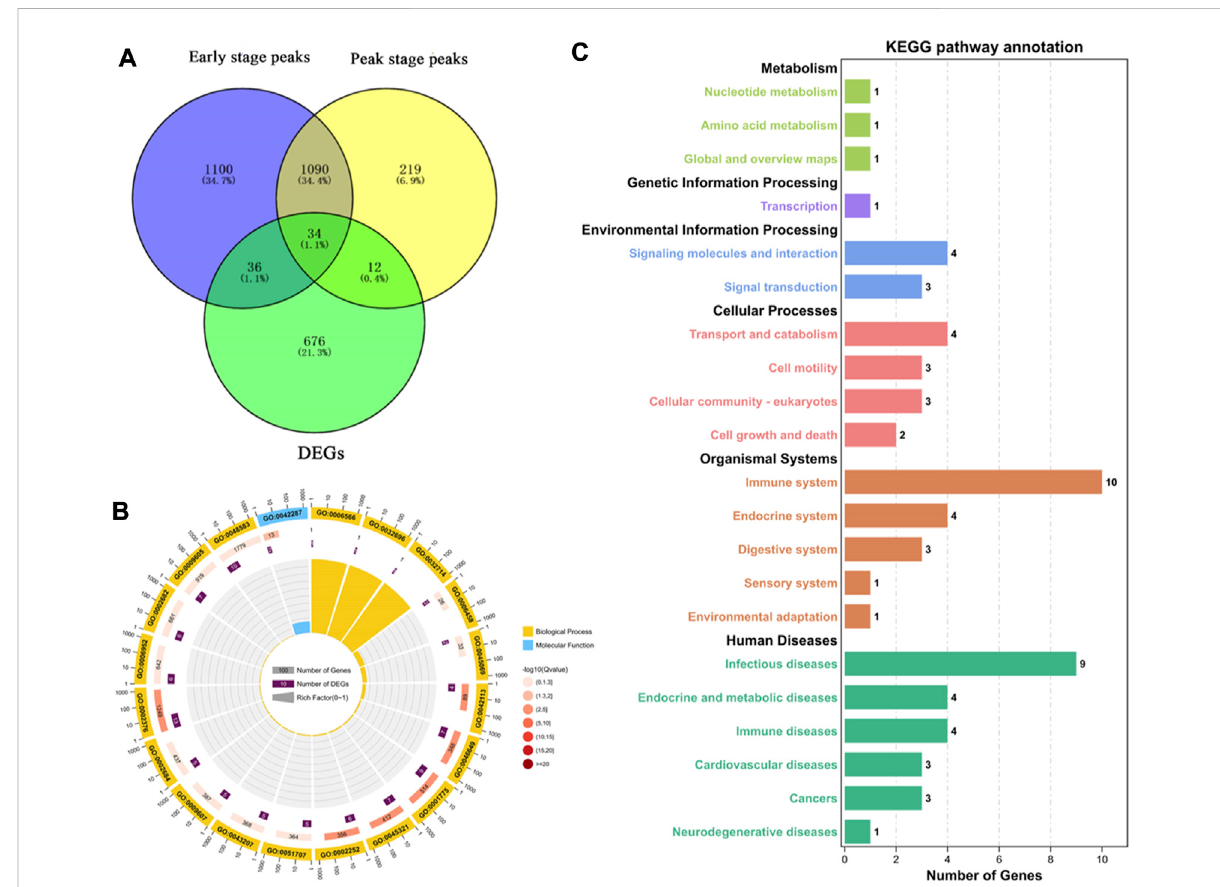
FIGURE 6 FunctionalanalysisofpeakenrichedDEGsduringearlyandpeaklactationstages. (A) Venndiagramofpeakdistributionindifferentialexpression genes between early and peak lactation stages. (B) GO enrichment analysis of the 34 common peak DEGs. (C) KEGG enrichment analysis of the 34 common peak